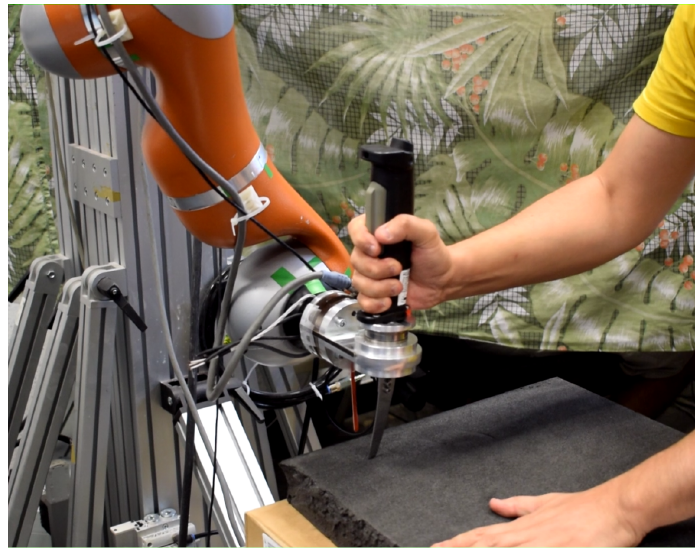
Figure 29. Foam cutting along the global